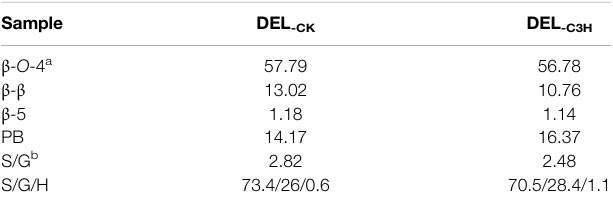
TABLE 4 | Quanti fi cation of lignin fractions by quantitative 2D-HSQC NMR spectroscopy.